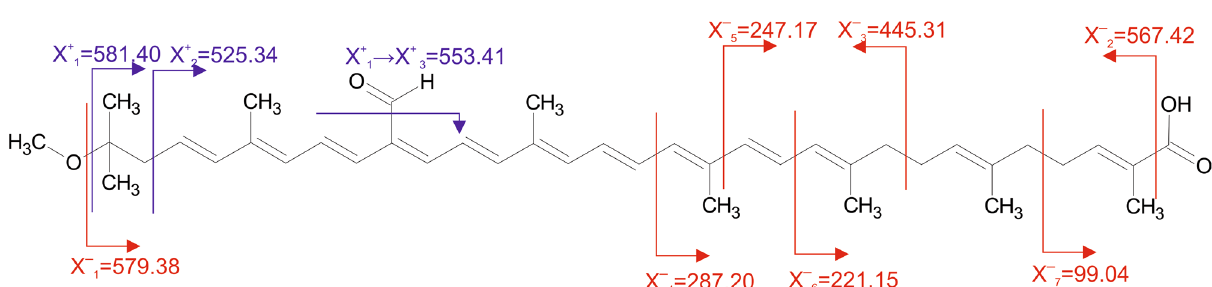
Figure 3. The most prominent MS/MS product ions provided by gemmatoxanthin molecular and demethoxylated ions in the positive (blue) and negative ionization mode (red). For detailed information, refer to the Supplementary Tables S1, S2 and Fig.